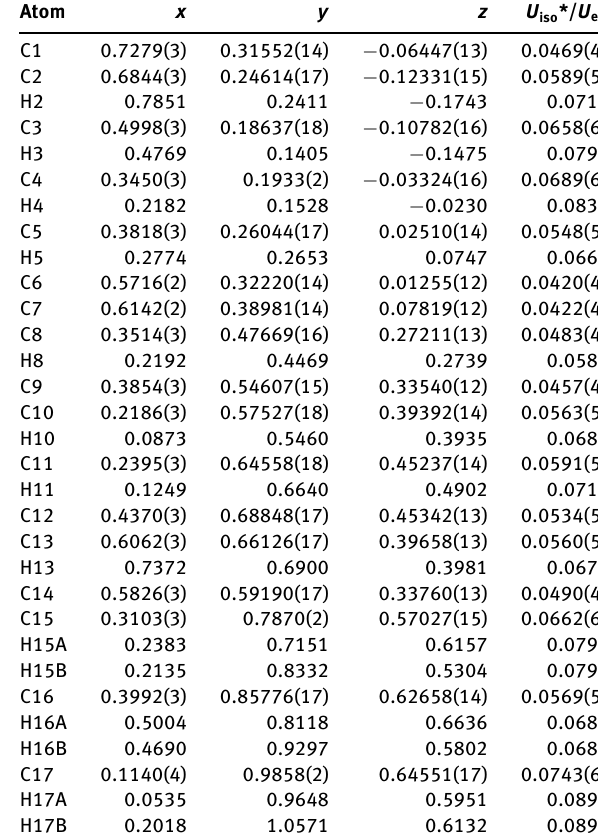
Table 2: Fractional atomic coordinates and isotropic or